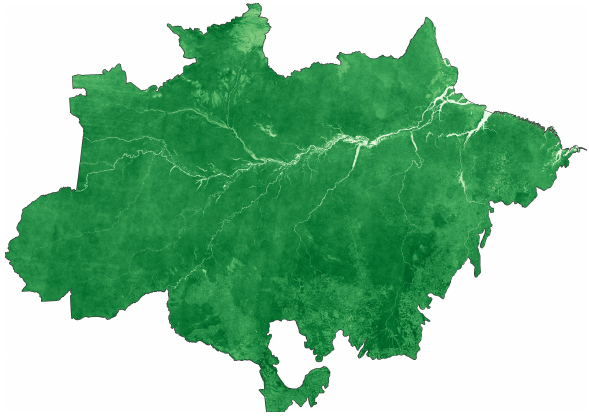
Figure 6. Temporal NDVI Mean from Landsat-8/OLI collection